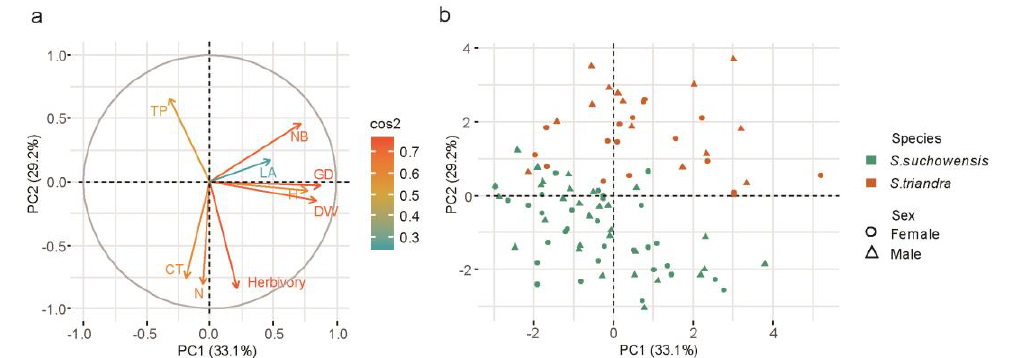
Figure 4. Principle component analysis (PCA) of the selected variables. ( a ) Relationships between all the variables; ( b ) under different species and genders. Notes: The variables are listed as follows: N, N concentration; CT, condense tannin; TP, total phenol; Herbivory, insert herbivory; DW, shoot dry weight; GD, ground diameter; H, plant height; NB, number of lateral branches; LA, leaf area. cos2 value indicates contribution of variables in PCA results.